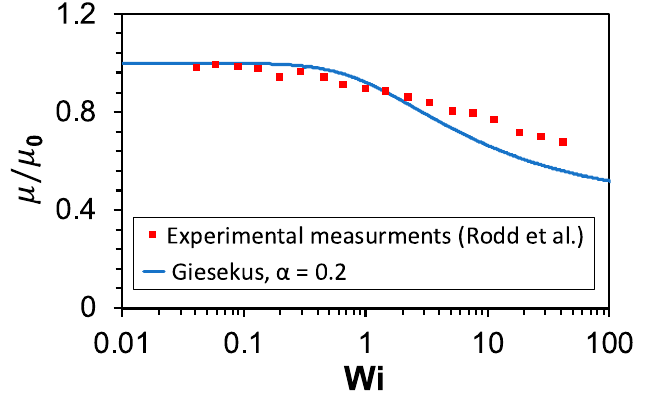
Figure 3. Shear-thinning behavior of the 1000 ppm PEO solution. Comparison of the normalized viscosity as a function of Wi number between experimental measurements by Rodd et al. [58] and the Giesekus model with the mobility factor α = 0.2.